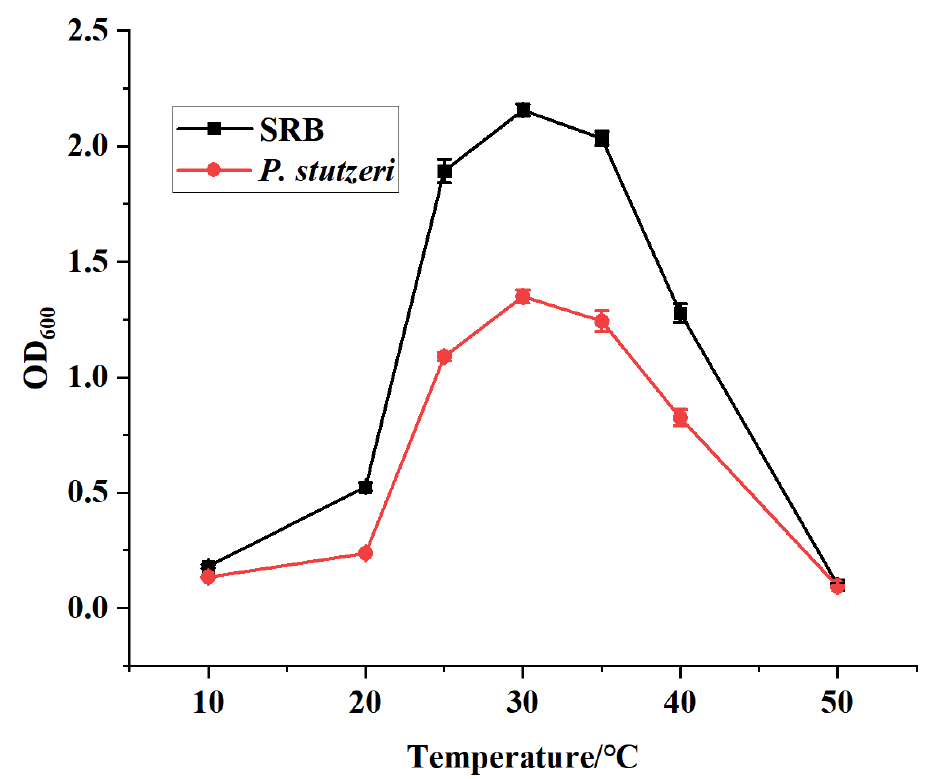
Figure 3. Effect of temperature on strain growth.